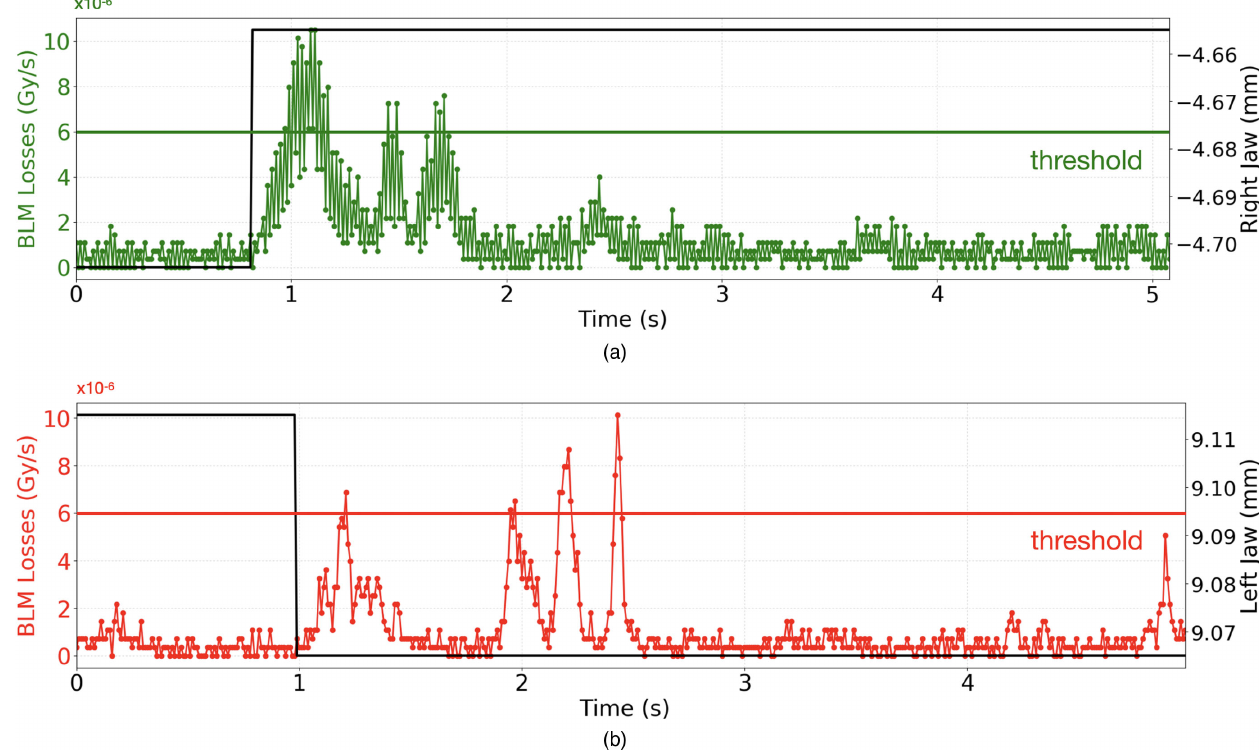
FIG. 6. Typical BLM signals as a function of time showing examples of (a) an alignment spike and (b) nonalignment spikes, after a collimator movement towards the beam